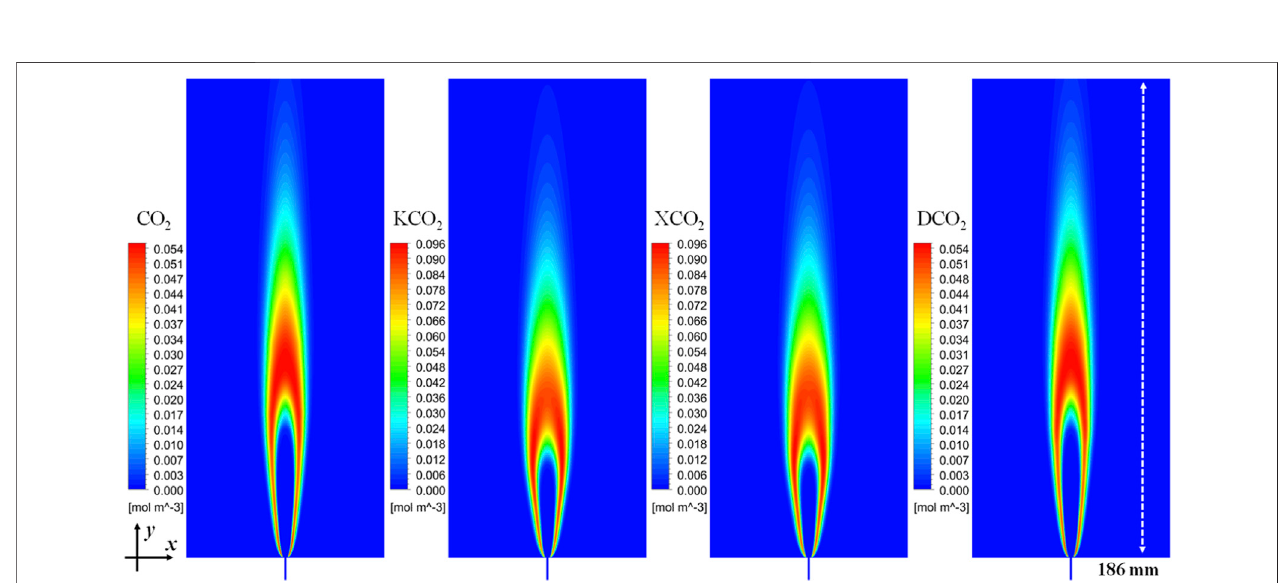
FIGURE 8 | Computational OH radical distributions in fl ames in different oxidizers ( V F = 10 m/s).